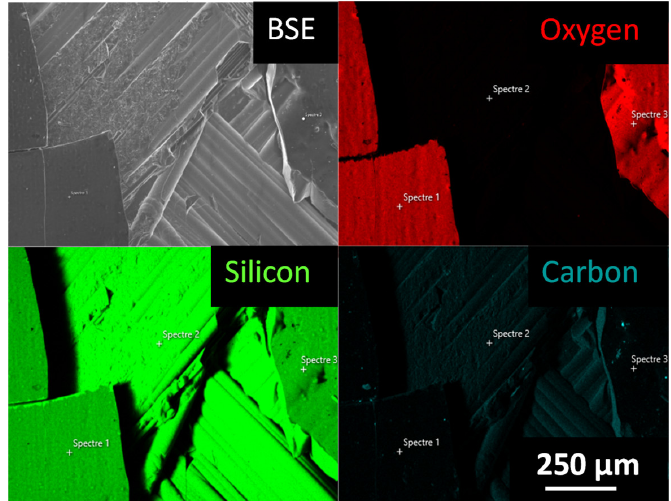
Figure 12. BSE and oxygen, silicon and carbon element mappings (EDS) of the SiC-02 surface after mechanical test up to failure. No oxygen content is measured under the sealcoat, which was removed during the tensile test.